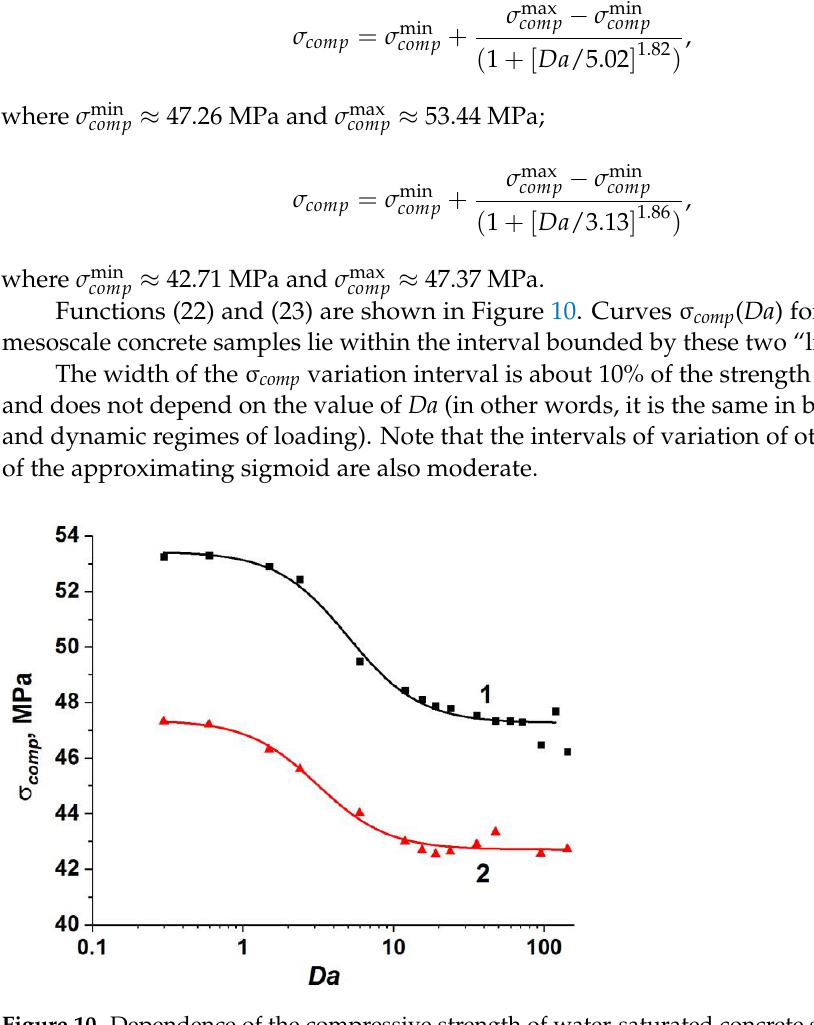
Table 4. Parameters of the logistic dependence of the uniaxial compressive strength of high-strength concrete with a two-scale porosity (6 vol.% of capillary pores and 4 vol.% of mi- cropores) on the generalized loading rate parameter Da .